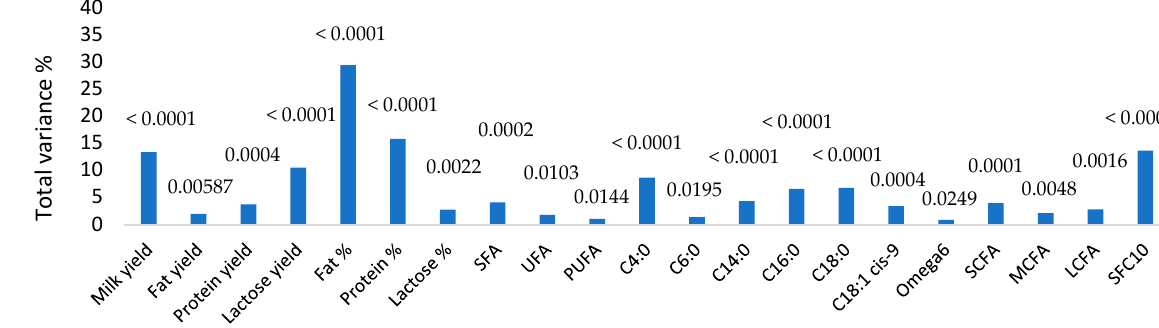
C16:0 and C18:0. The SNP did not control a significant proportion of variance for fatty acids C8:0, C10:0, and C12:0. Approximately 14% of the variance was explained by the SNP for the variable SFC 10 .